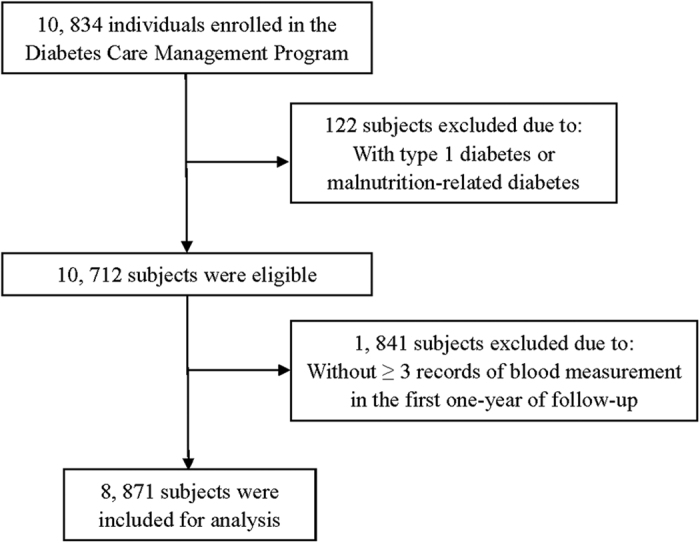
Flow chart of recruitment procedures of study participants for the current study.